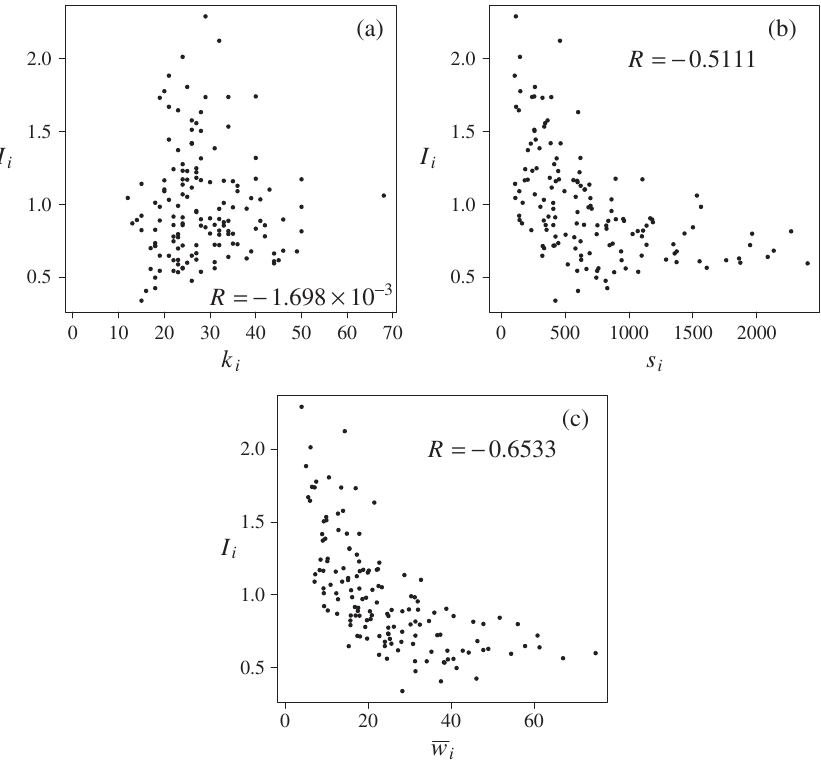
FIG. 6. Mutual information I i is plotted against (a) degree k i , (b) node strength s i , and (c) average node weight (cid:1) w i , for D Pearson correlation coefficient R between the plotted quantities is also